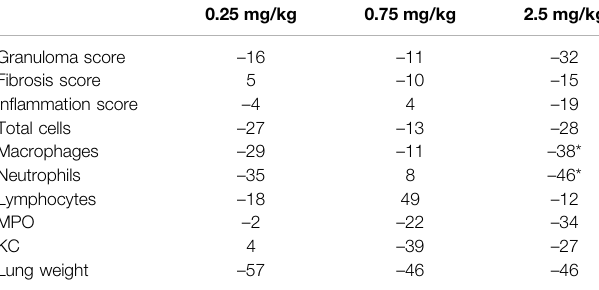
TABLE 4 | Effects of BI 1015550 in the mouse model of silica-induced lung fi brosis. Results are given as % change related to control animals. Each treatment group contained 10animals. Negative values indicate areduction ofthe parameter indicated. Lung histology was done semi-quantitatively after hematoxylin and eosin and chromotrope-aniline blue staining (see scores). Cell counts, MPO, and KC were determined in BALF. *, p < 0.05. BALF,